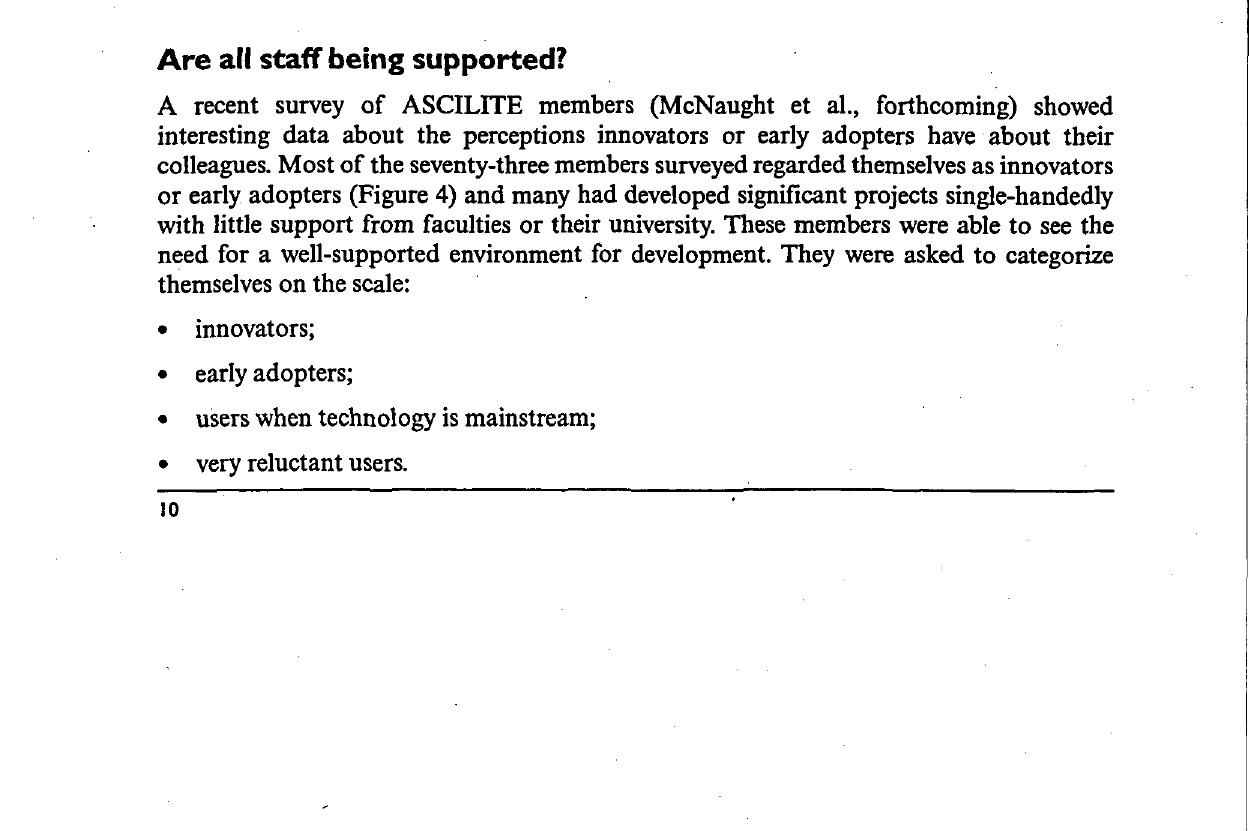
Are all staff being